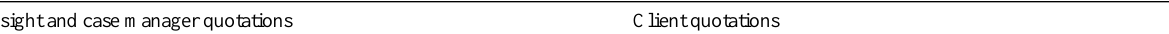
Table 2. Supporting insight quotations from semi-structured interviews.